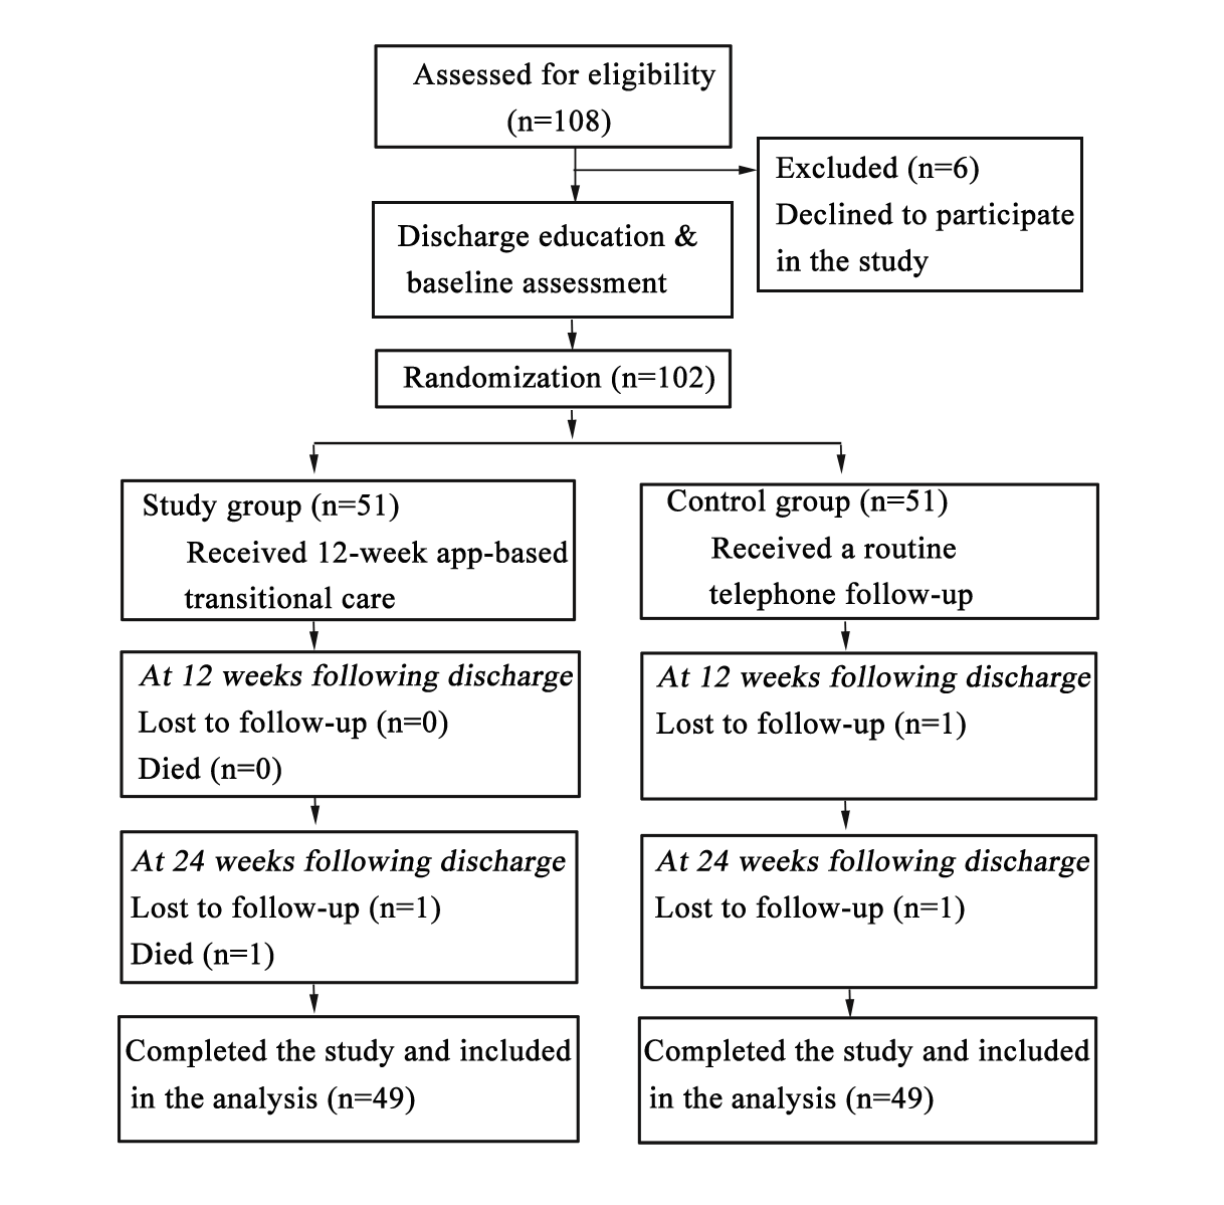
Figure 4. The CONSORT flow diagram of this